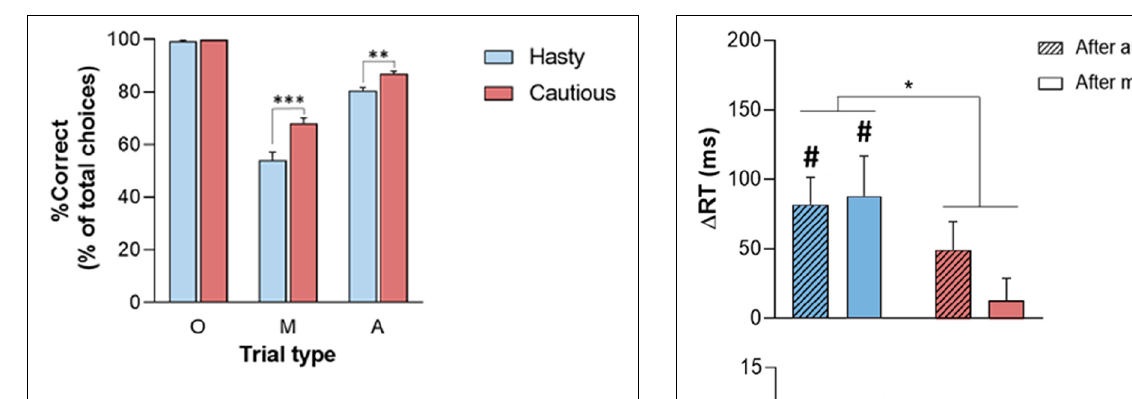
or CONTEXT × TRIAL n-1 _TYPE interaction ( F 1, 28 =